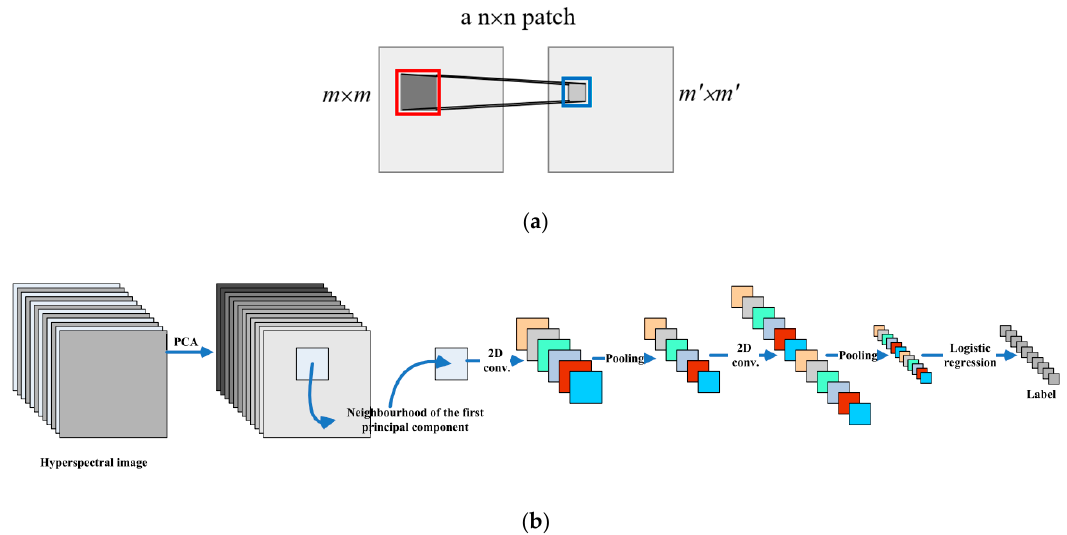
Figure 2. ( a ) A typical 2D convolution; ( b ) 2D-CNN classification framework in [15]. After PCA for dimension reduction, the framework contains two 2D convolutional layers, two pooling layers, and an output layer.